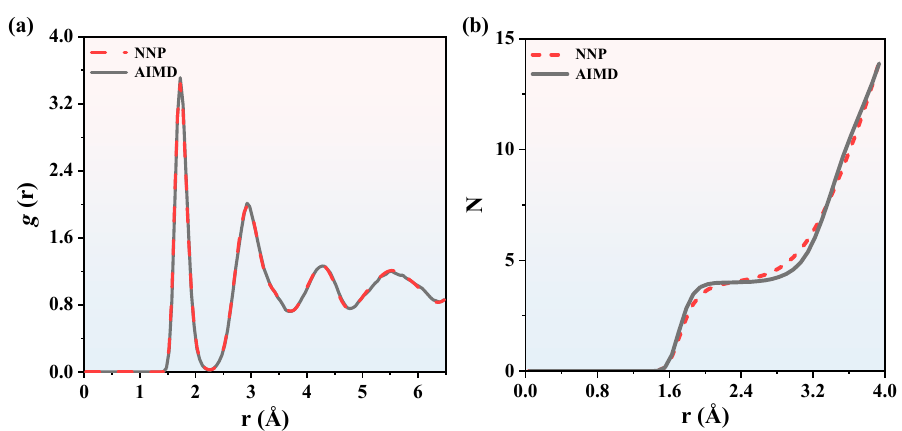
Figure 3. The comparisons of ( a ) Si 3 N 4 RDFs between NNP + MD and AIMD calculations and ( b ) Si 3 N 4 CNs between NNP + MD and AIMD calculations. The temperature is 2000 K.